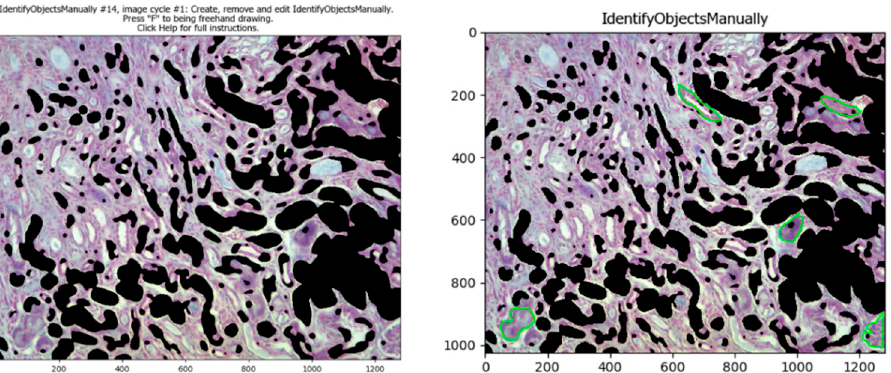
Figure 5. Manual identification of objects. The IdentifyObjectsManually module, if enabled, lets the user select objects or areas in the image (manually selected areas are in green after the freehand drawing).